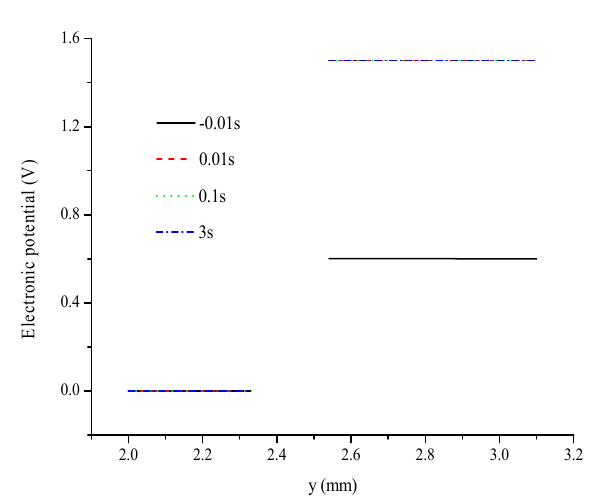
Figure 11. Evolution of electronic potential with time along line A–A in operation mode switching.